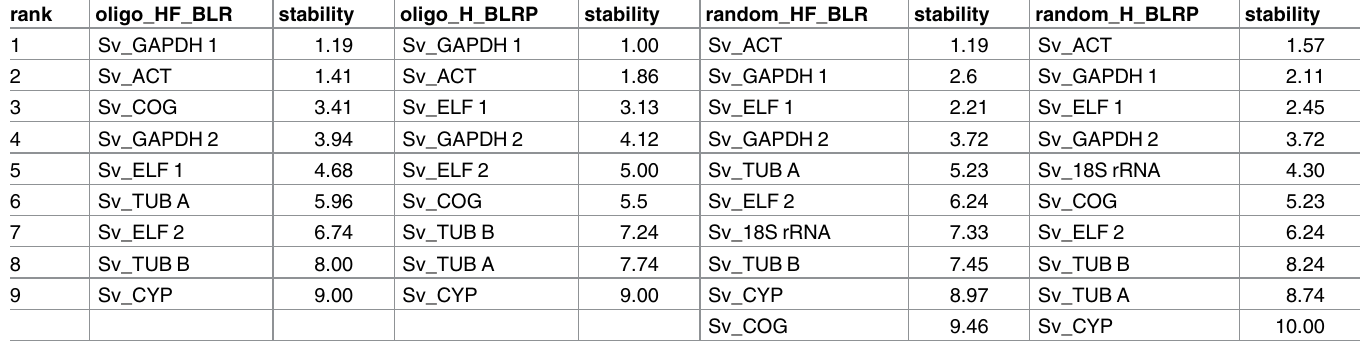
* RefFinder stability values represent geometric means of ranking values